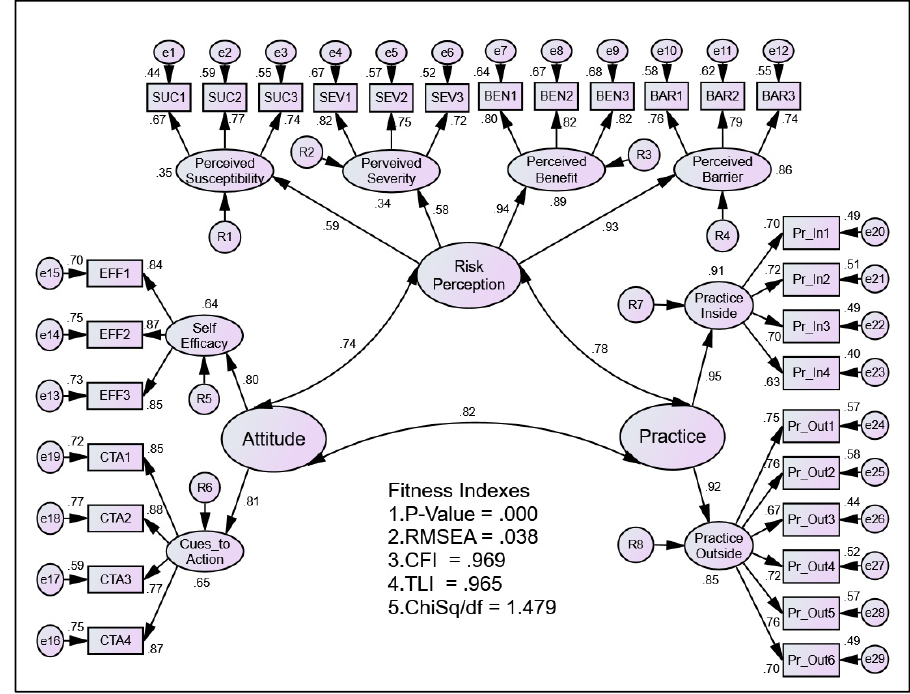
Figure 3. The results of Pooled-CFA show factor loading for all components as well as all items measuring their respective components. Table 4. The Average Variance Extracted (AVE) and Composite Reliability (CR).